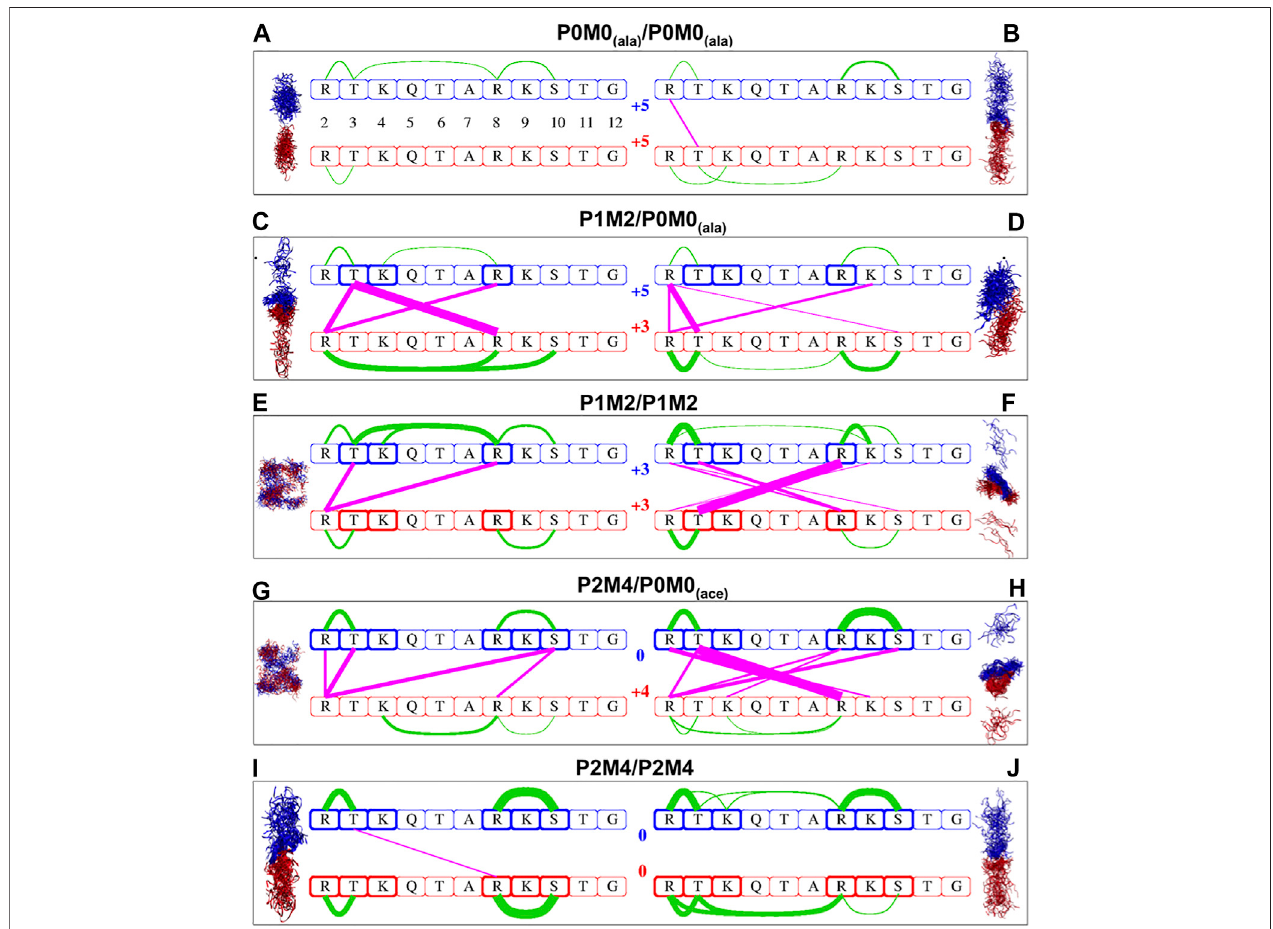
FIGURE1| Intra- and intermolecular interactions indifferentiallymodi fi ed H3peptidepairs. Conformationalsamplingbased on80framesper trajectoryfor each of the fi ve pairs of differentially modi fi ed H3 peptides studied. Con fi gurations derived from MD simulations for the originally α -helical conformations are shown on the left side,whilethosefrominitiallyextendedconformationsareshownontherightside.Redandblueribbonsrepresentthe fi rstandsecondpeptideofeachpair,respectively; watermolecules arenot included. The same color codeis used inthe linear schematic representation in thecenterwith theH3 residues 2 – 12in boxes. Green lines indicate intra-oligopeptide interactions and magenta lines inter-oligopeptide interactions; the thickness of the lines is proportional to the percentage of total simulation time during which the individual residues are in close contact, ranging from 10% of the time (thinnest lines) to 98% of the time (thickest lines). The residues in bold boxes are the ones that have been phosphorylated (T 3 , S 10 ) or methylated (R 2 , K 4 , R 8 K 9 ).